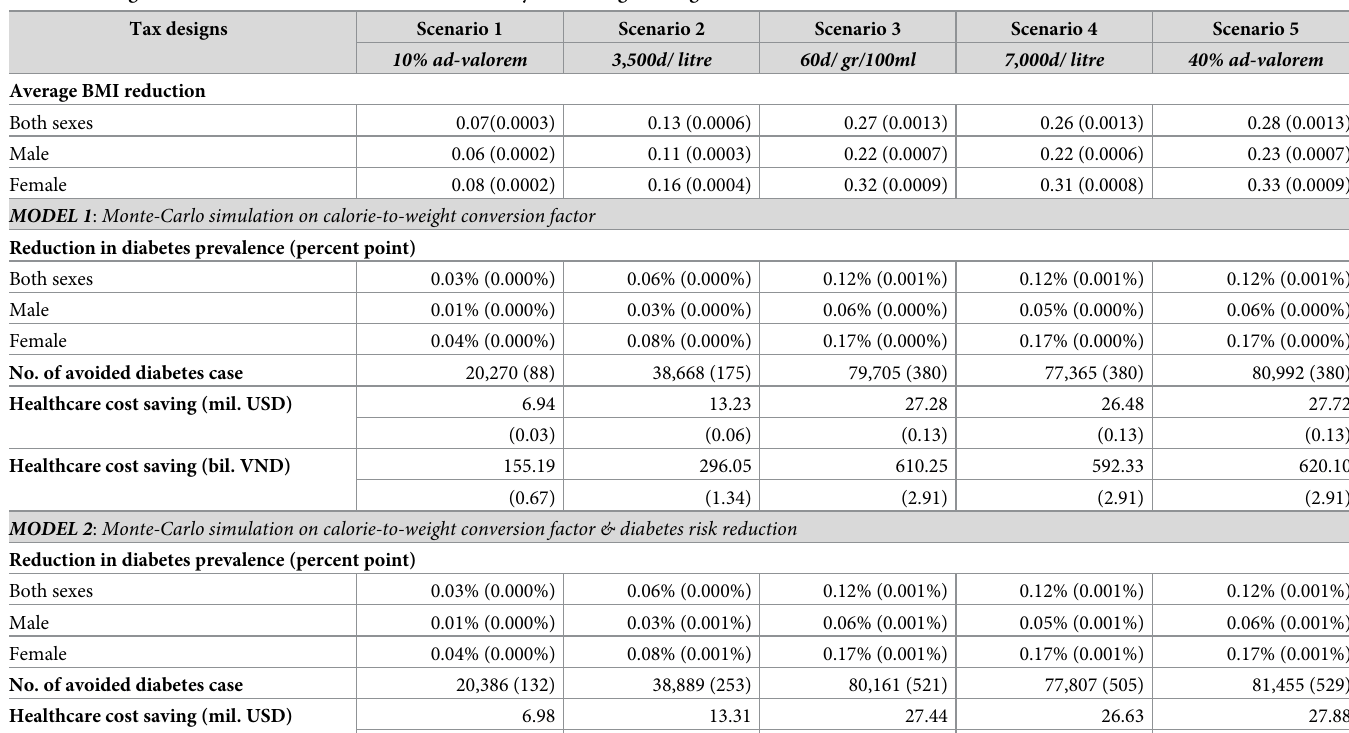
Table 5. Changes in the burden of diabetes mellitus induced by excess weight